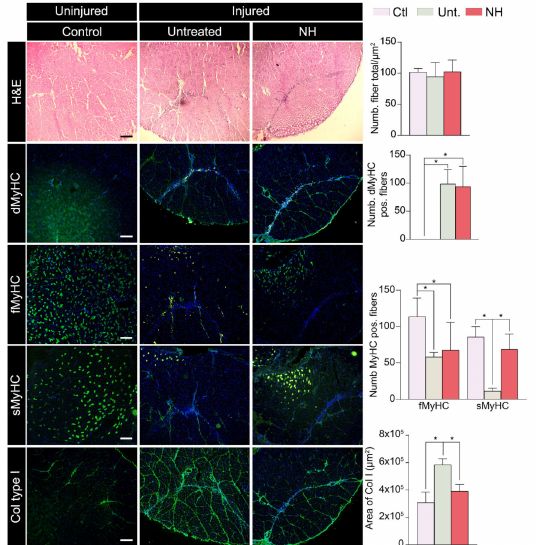
Figure 2. NeuroHeal reduces collagen deposition and promotes slow-twitch fiber typing after muscle injury. Left , representative microphotographs of contralateral control healthy gastrocnemius (GA) muscle sections (Ctl) and lesioned GA muscle sections from the injured untreated (Unt.) and injured treated with NeuroHeal (NH) groups at 14 dpi. Scale bar 500 µ m, for all corresponding microphotographs as represented in the first image panel, the control condition. First panel , left , representative microphotographs of GA muscle sections stained with H&E. Right , bar graph of the average number of muscle fibers ( n = 4; t -test). Second panel , left , representative microphotographs of GA muscle sections immunostained for developmental MyHC. Right , bar graph of the average number of positive fibers for dMyHC related to the total area of the image ( n = 4; t -test). Third and fourth panels , left , representative microphotographs of GA muscle sections immunostained for fast and slow MyHC. Right , bar graph of the average number of positive fibers for fMyHC and sMyHC related to the total area of the image ( n = 3; t -test, * p < 0.01). Fifth panel , left , representative microphotographs of GA muscle sections immunostained for Collagen type I (Col I). Right , bar graph of the average of the area immunolabeled for Col I ( n = 4; t -test, * p <